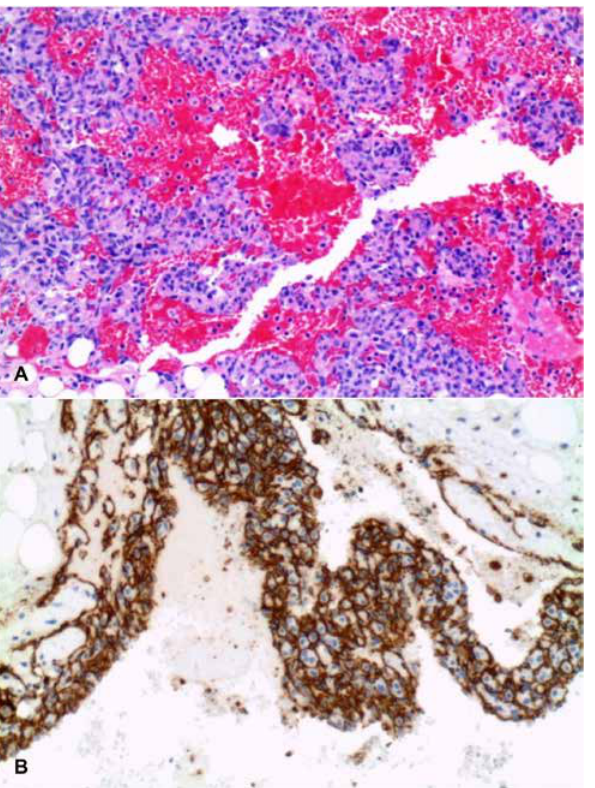
Figure 3: Angiosarcoma (as) of the kidney. (A) clusters of atypical spindle-shaped cells forming irregular vascular channels and rudi- mentary lumen formation (haematoxylin-eosin, 200x); (b) immunos- tain for cd31 shows intense staining of most as cells (200x).